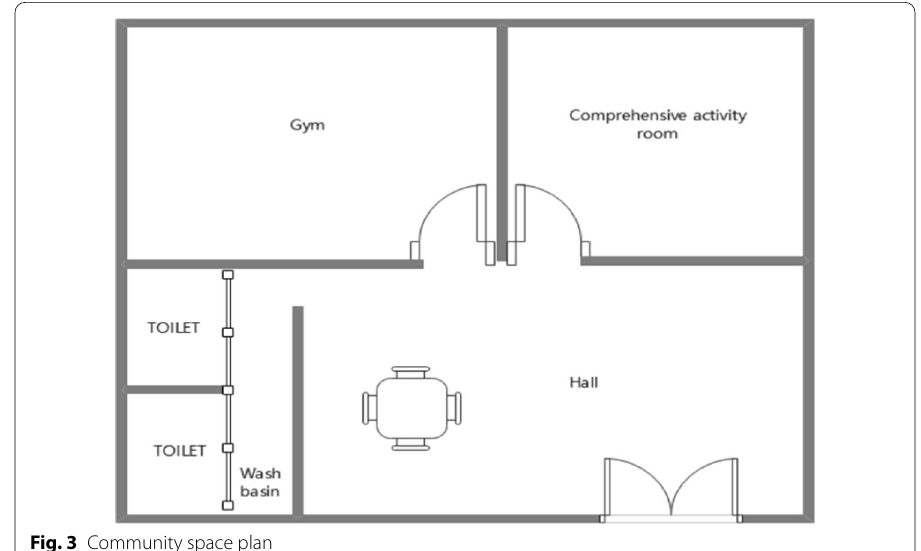
Fig. 3 Community space